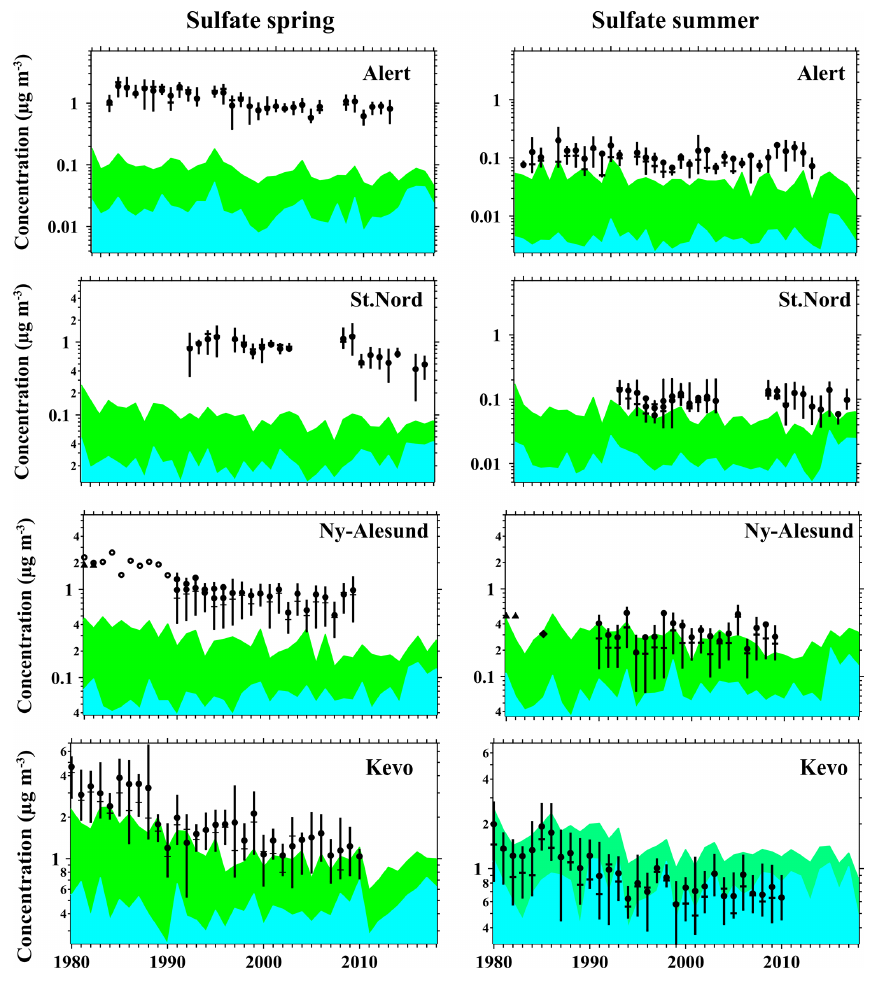
Figure 3. Surface concentrations of sulfate aerosols (µgm − 3 ) in spring (March–May) and summer (June–August) at four locations (Alert, Station Nord, Ny-Ålesund, Kevo) in the Arctic during 1980–2018. Seasonal means are denoted by solid black circles, medians as short horizontal bars, and the 25th to 75th percentile ranges as vertical bars. Stacked colors represent modeled contributions from the Arctic (blue) and non-Arctic (green) anthropogenic source region. The observations denoted by solid black circles are obtained from the European Monitoring and Evaluation Programme, World Data Centre for Aerosols database (http://ebas.nilu.no, last access: July 2020), and Breider et al. (2017). Black triangles at Ny-Ålesund for the period 1980–1981 show mean observations from Heintzenberg and Larssen (1983). The black diamond at Ny-Ålesund in summer shows the median non-sea-salt sulfate concentration from Maenhaut et al. (1989). Open circles in the spring for Ny-Ålesund are March–April mean values (Sirois and Barrie, 1999). Note that the vertical coordinates use logarithmic